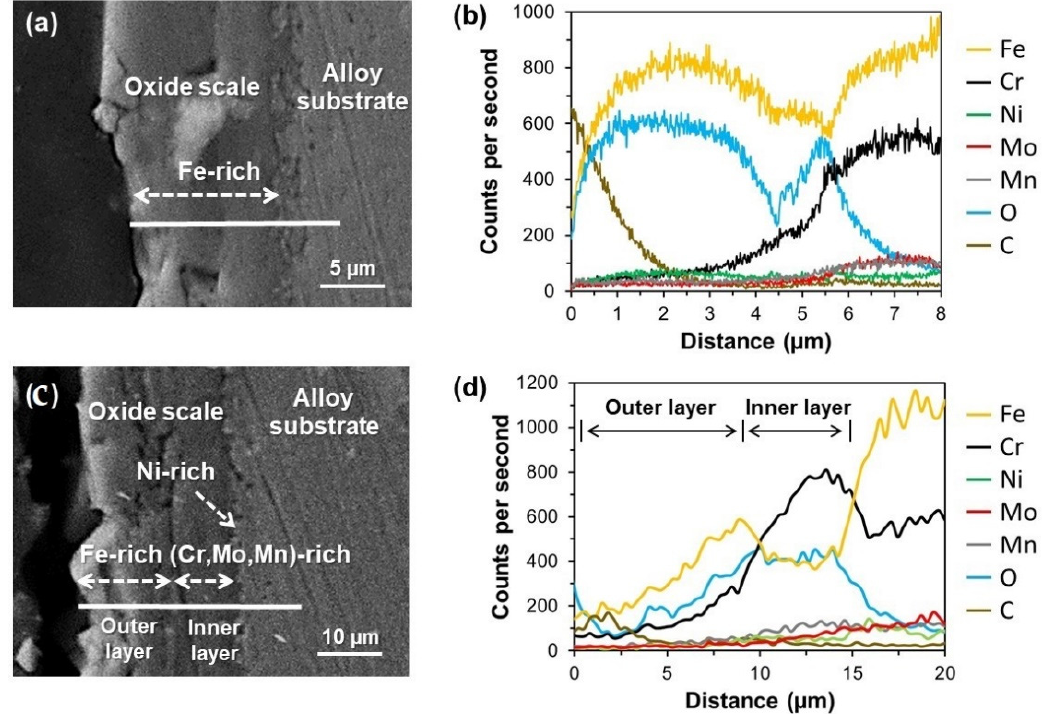
Figure 5. Cross-sectional SEM images and EDS line-scan analyses corresponding to the white line of DS2205 exposed to molten salts for: ( a , b ) 300 h, and ( c , d ) 1600 h.